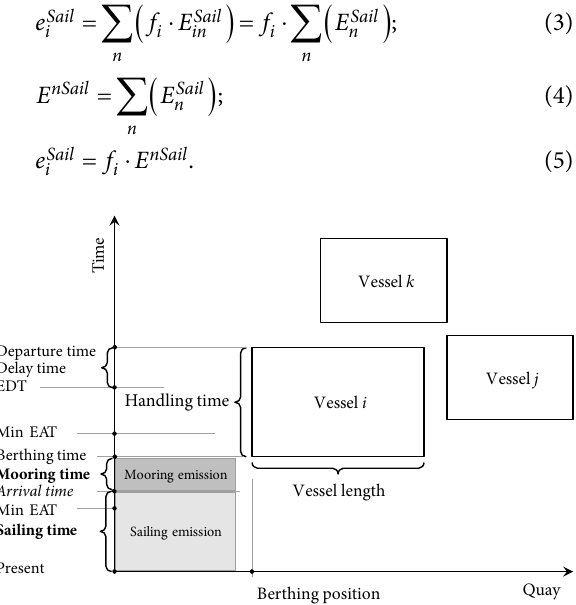
Figure 1. The times describing the delay and emissions in a BAP